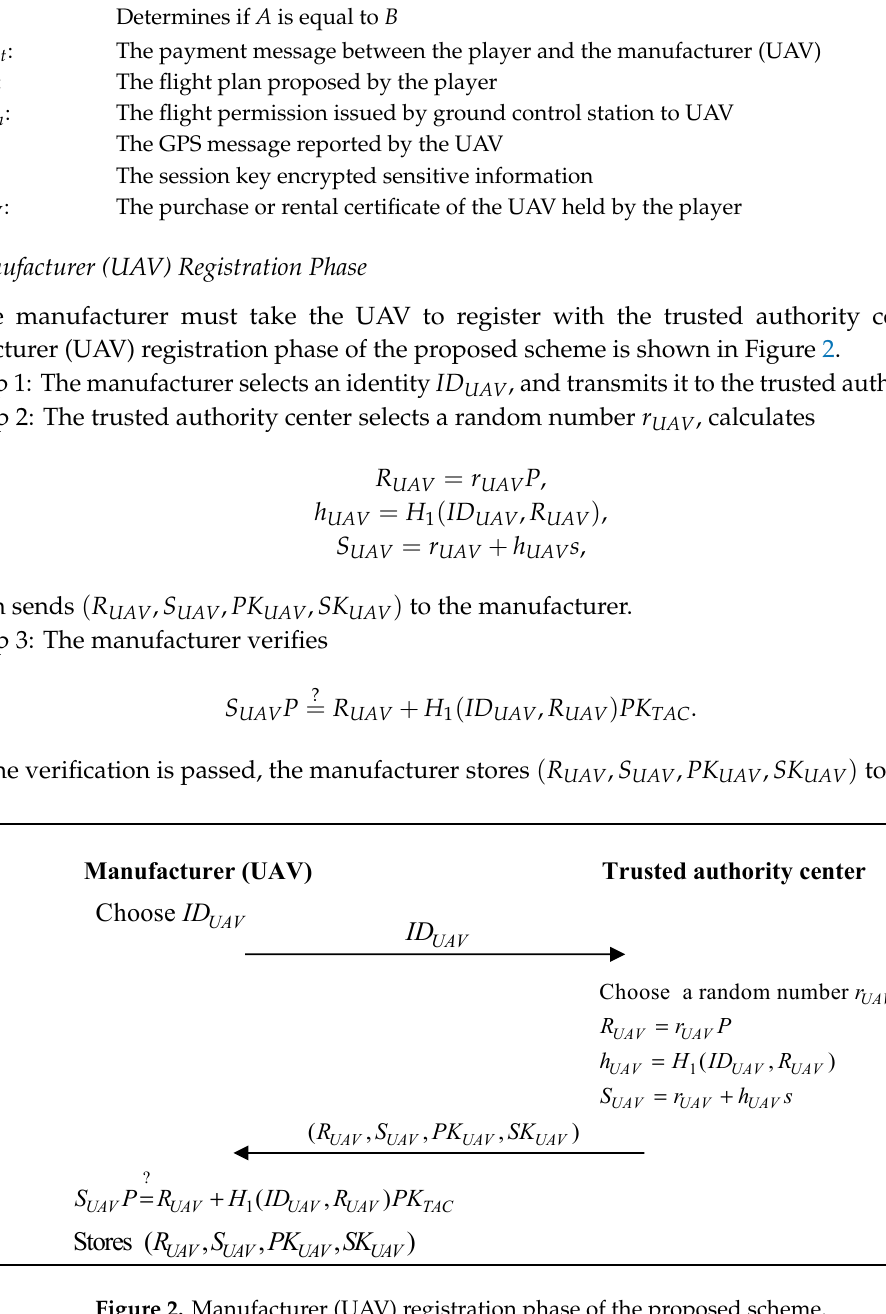
Figure 2. Manufacturer (UAV) registration phase of the proposed scheme.